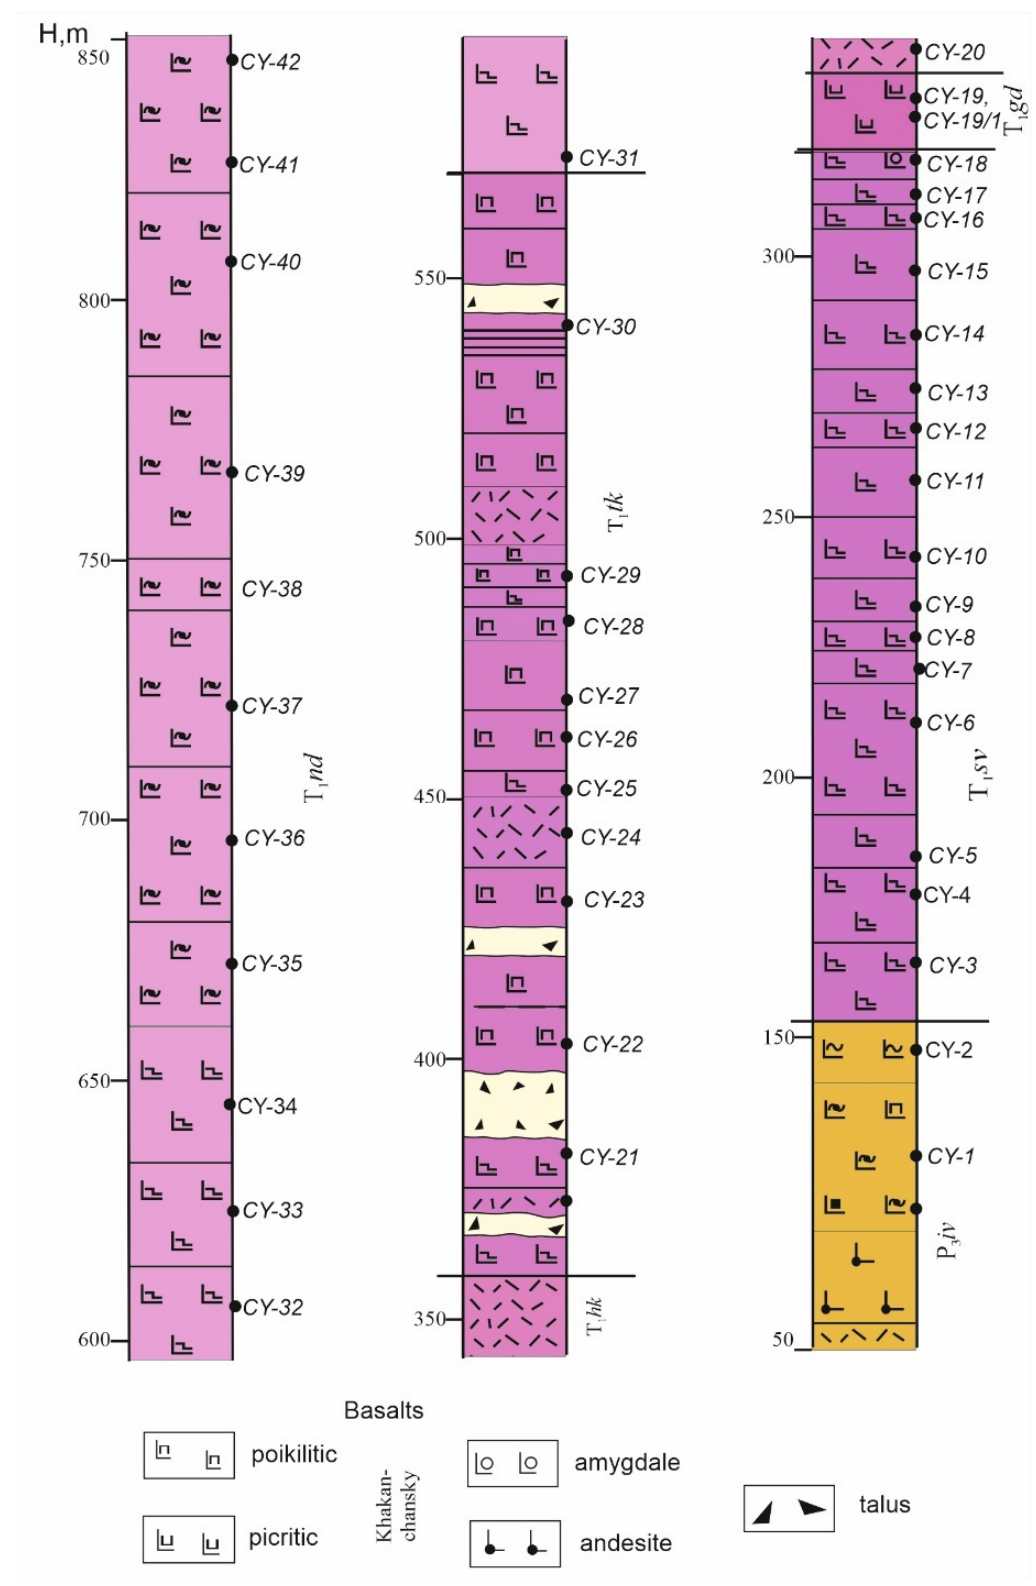
Figure 6. The structure of the volcanic sequence in Mount Sunduk. Captions in Figure 4. H, m— absolute altitude in meters.